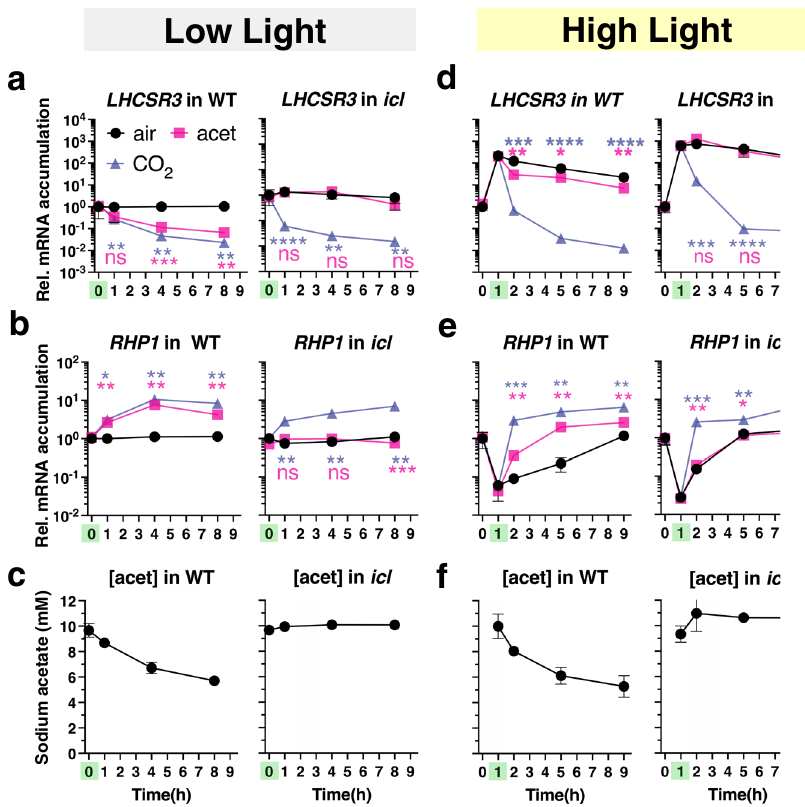
Fig. 2 | LHCSR3 inhibition is driven by CO 2 derived from the metabolism of acetate. Experiment at LL: a , b mRNA accumulation of LHCSR3 and RHP1 and c concentration of sodium acetate in the growth medium in WT and icl strains. Cells were acclimated overnight at LL (15 µ mol photons m − 2 s − 1 ) in HSM sparged with air. At t=0 cells either continued being sparged with air (labelled “ air ” ); or sparged with air and supplemented with 10mM sodium acetate (labelled “ acet ” ); orsparged withairenrichedwith5%CO 2 (labelled “ CO 2 ” ).Theaddition ofacetate or CO 2 is indicated with a green mark on the x-axis. Samples were taken at t=0, 1h, 4h and 8h. Experiment at HL: d , e mRNA accumulation of LHCSR3 and RHP1 and f concentration of sodium acetate in the growth medium in WT and icl strains. Cells were acclimated overnight at LL (15 µ mol photons m − 2 s − 1 ) in HSM spargedwithair;att=0lightintensitywasincreasedto600 µ molphotonsm − 2 s − 1 .